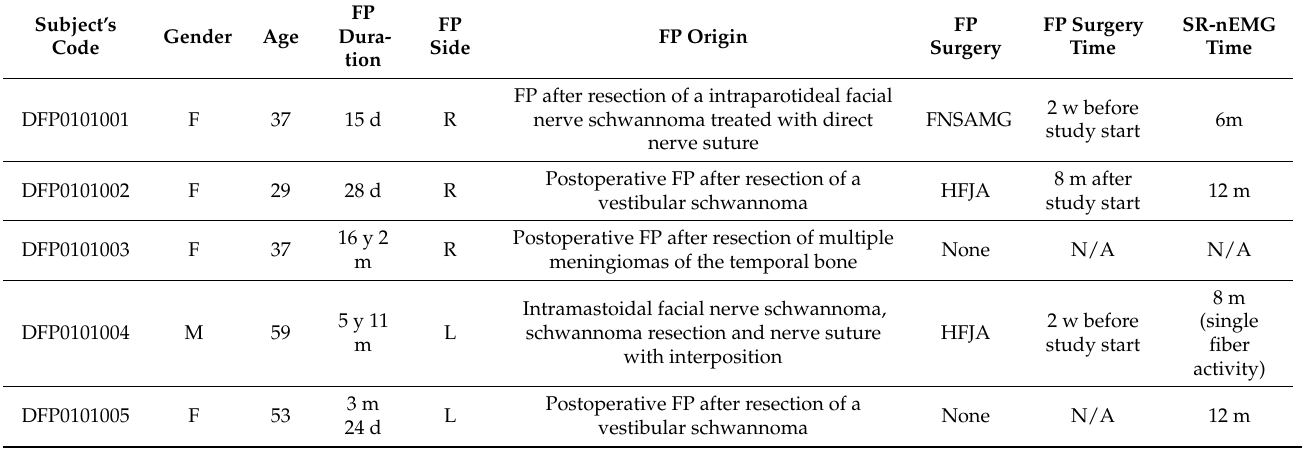
Table 1. Patients’ demographic data and facial paralysis history. FP = facial paralysis; F = female; M = male; SR-nEMG time = time during the study follow-up when synkinetic reinnervation signs were detected by means of n-EMG; d = days; m = months; y = years; R = right; L = Left; FNSAMG = Facial nerve suture with auricularis magnus nerve grafting; HFJA = hypoglossus-facial nerve jump anastomosis.